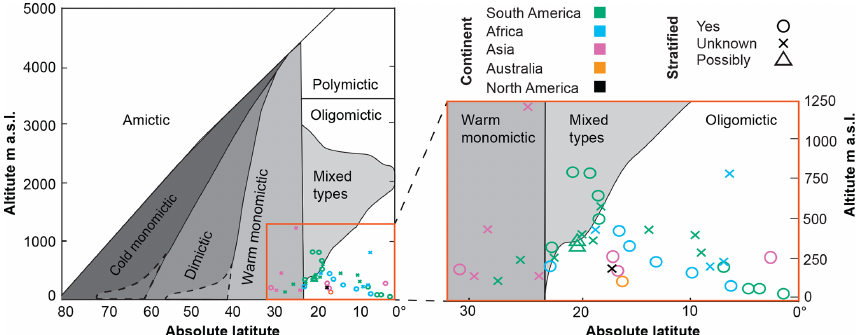
Figure 3. The 54 most-voluminous low-latitude reservoirs overlaid onto a lake classification diagram (redrawn from Hutchinson and Loffler,